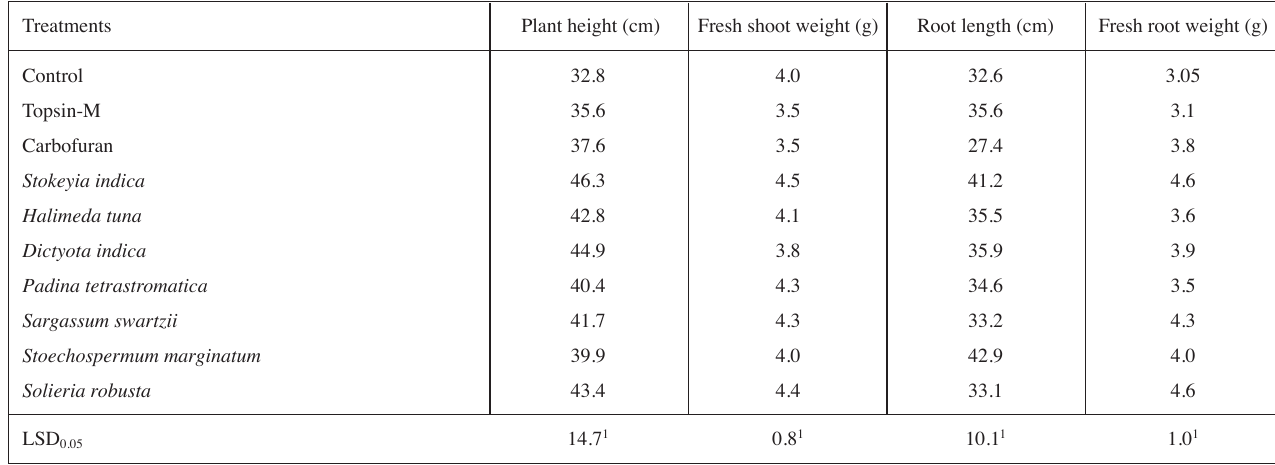
Tab. 2: Effect of seaweeds on the growth of soybean after 45 days of nematode inoculation in screen house experiment.